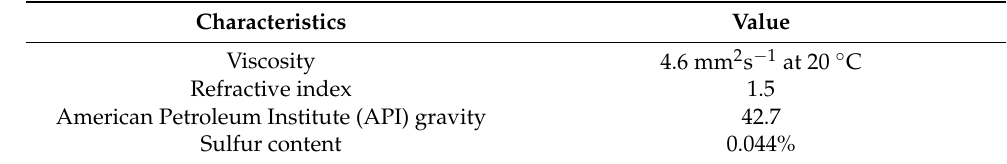
Table 2. Characteristics of the petroleum crude oil used in this